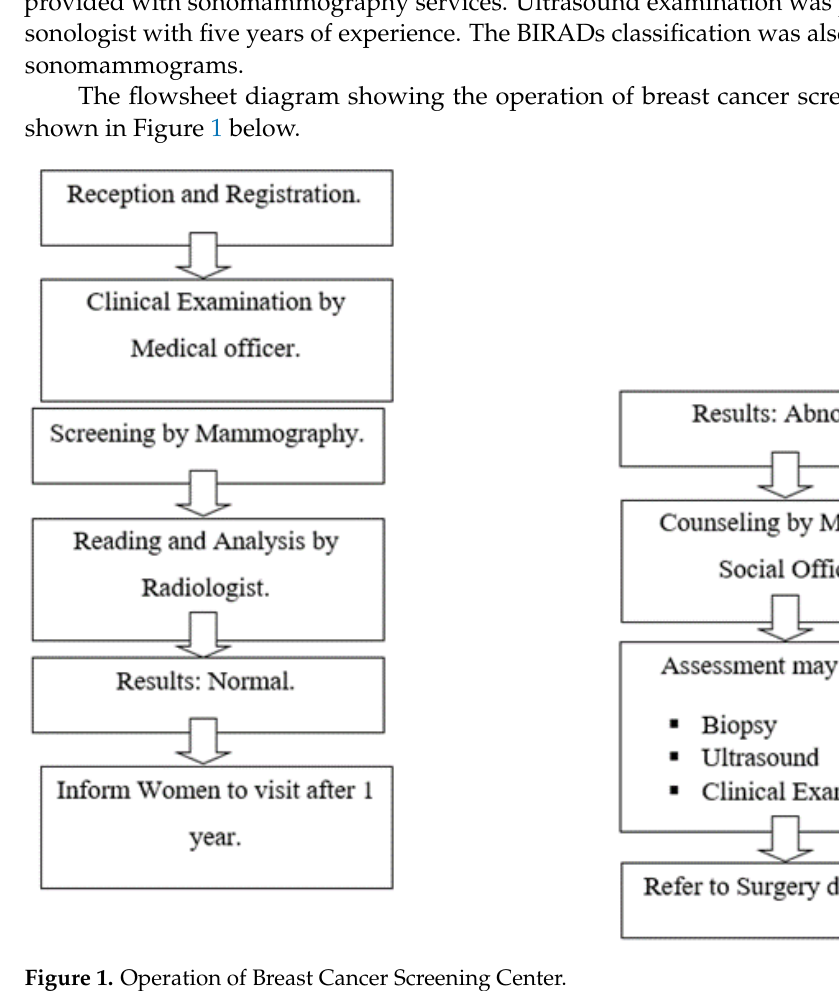
Figure 1. Operation of Breast Cancer Screening